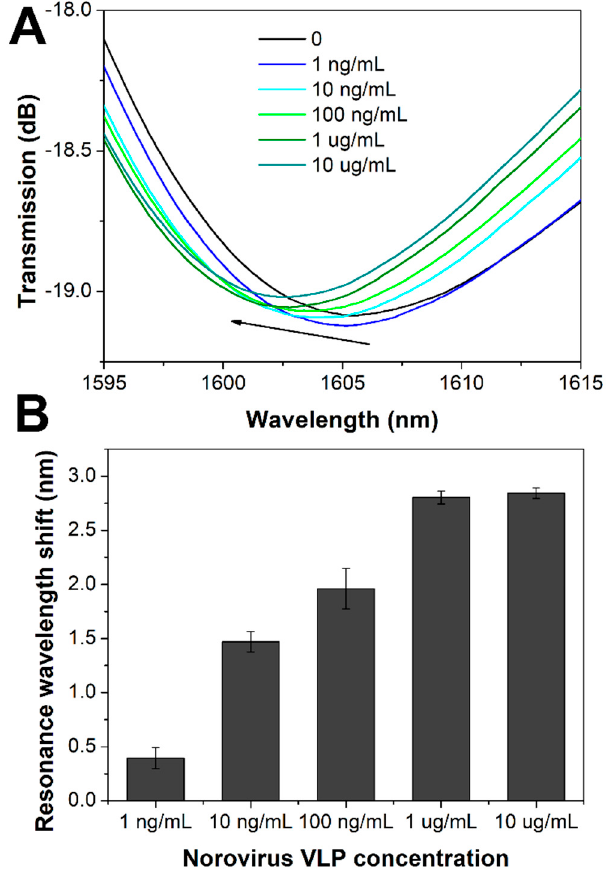
Figure 5. ( A ) Spectra measured in PBS before VLPs addition and after incubation in different concentrations of VLPs. The representative spectra are shown for each concentration. ( B ) Resonance wavelength shift for the left resonance referred to measurement performed in PBS before VLP addition for varied VLPs concentrations.